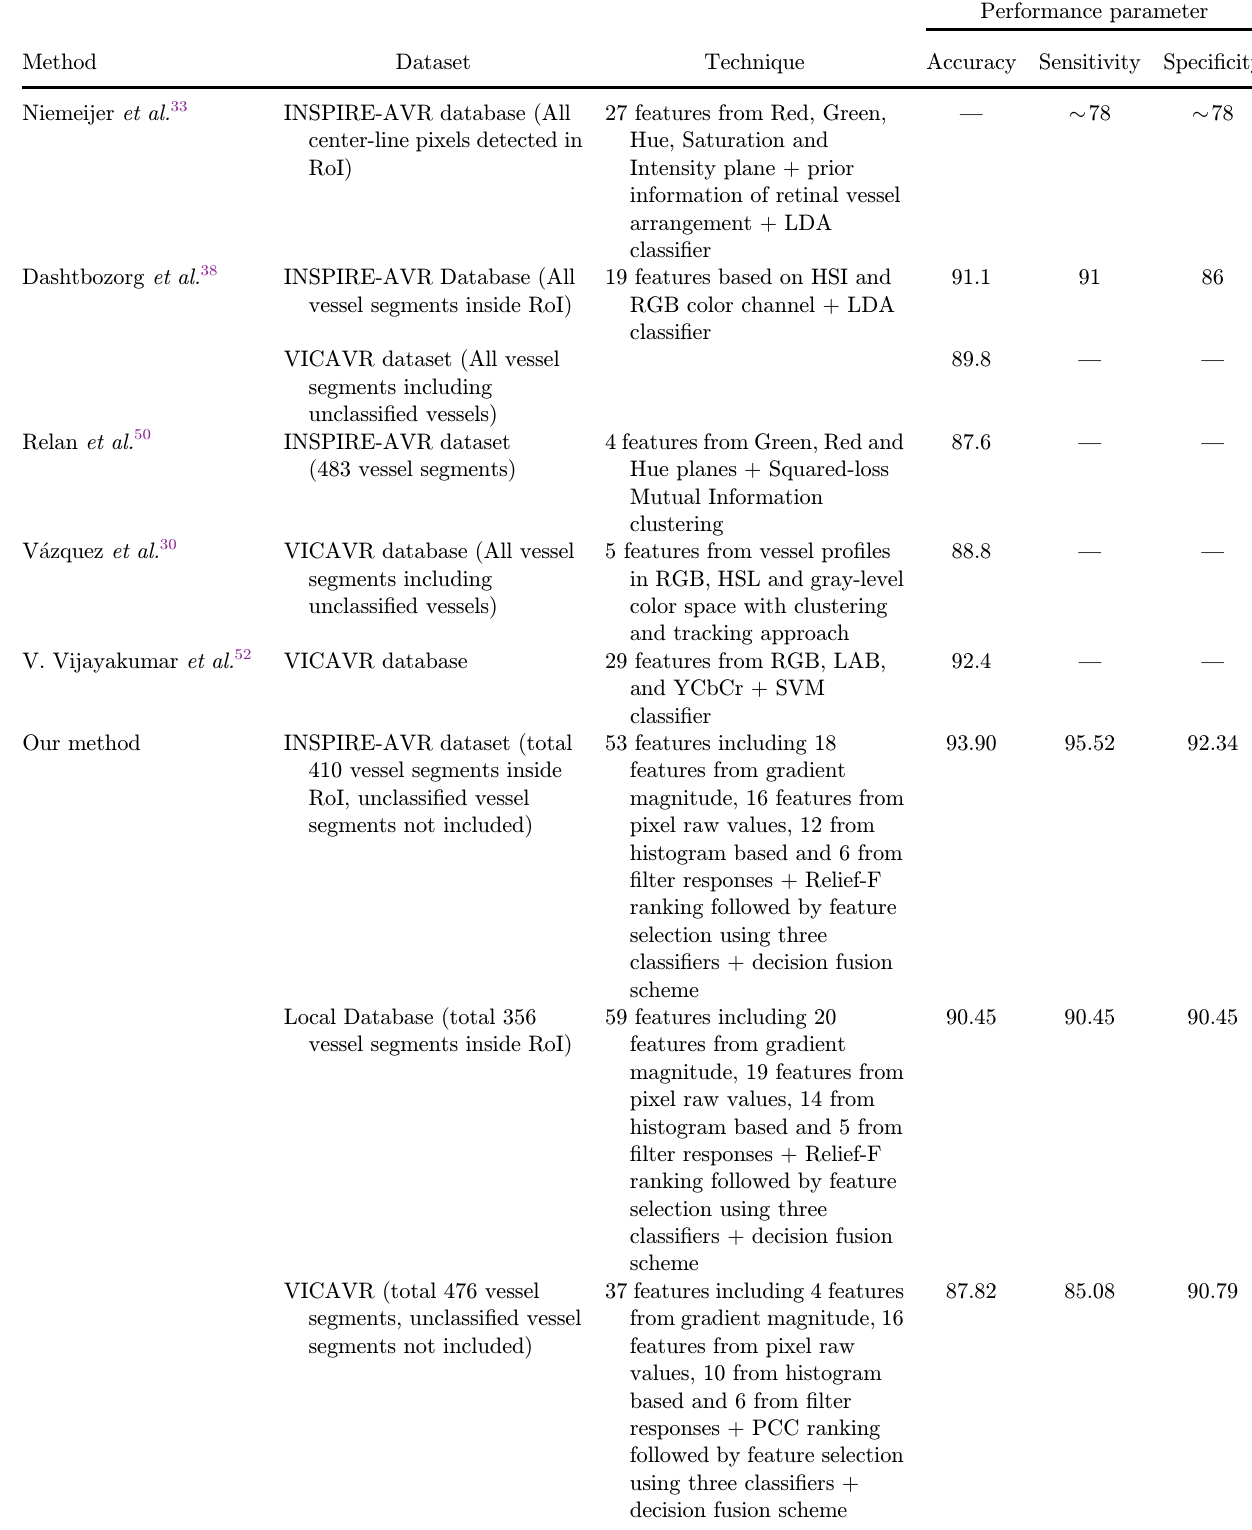
Table 7. Comparison of vessel classi¯cation with previous